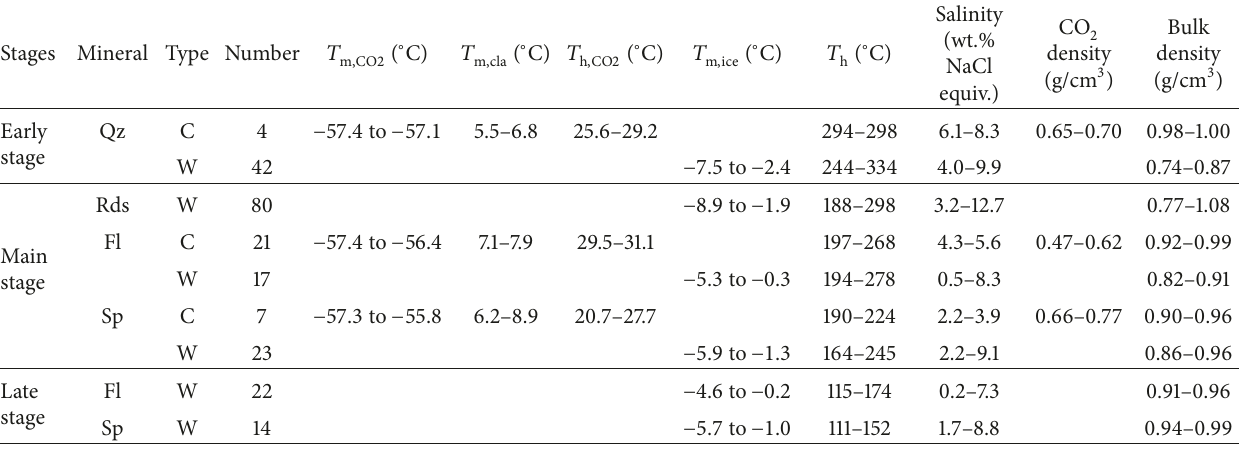
Table 1: Microthermometric data of fluid inclusions from different stages in the Zhijiadi Ag-Pb-Zn deposit.